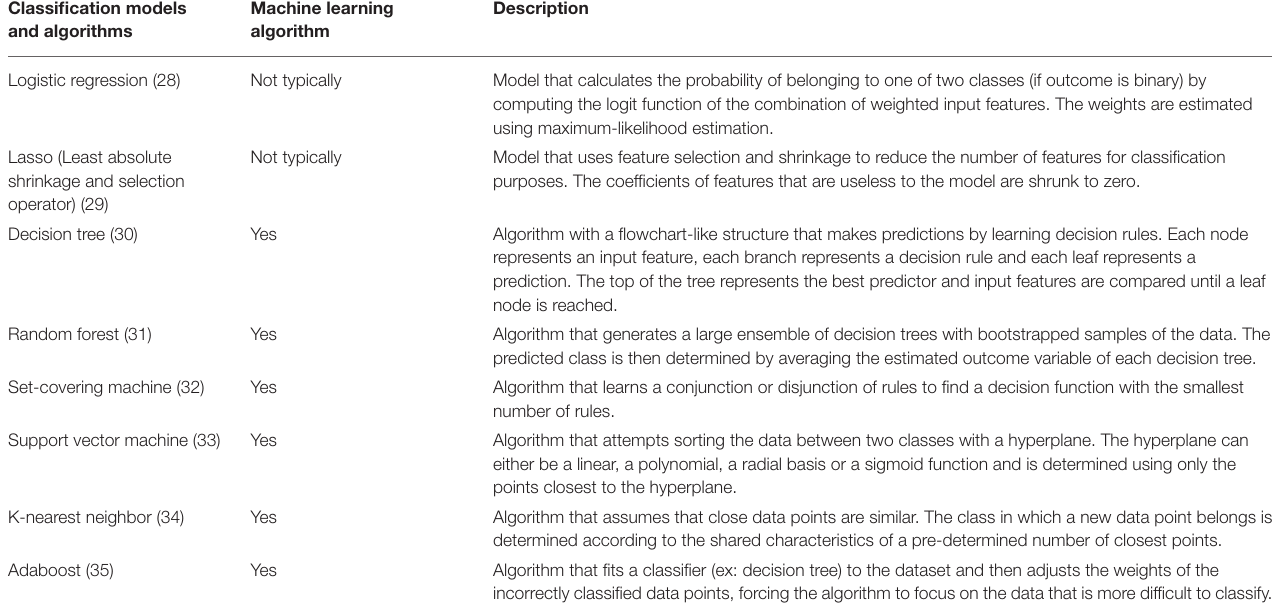
TABLE 1 | Model and algorithm description. Classification models and algorithms